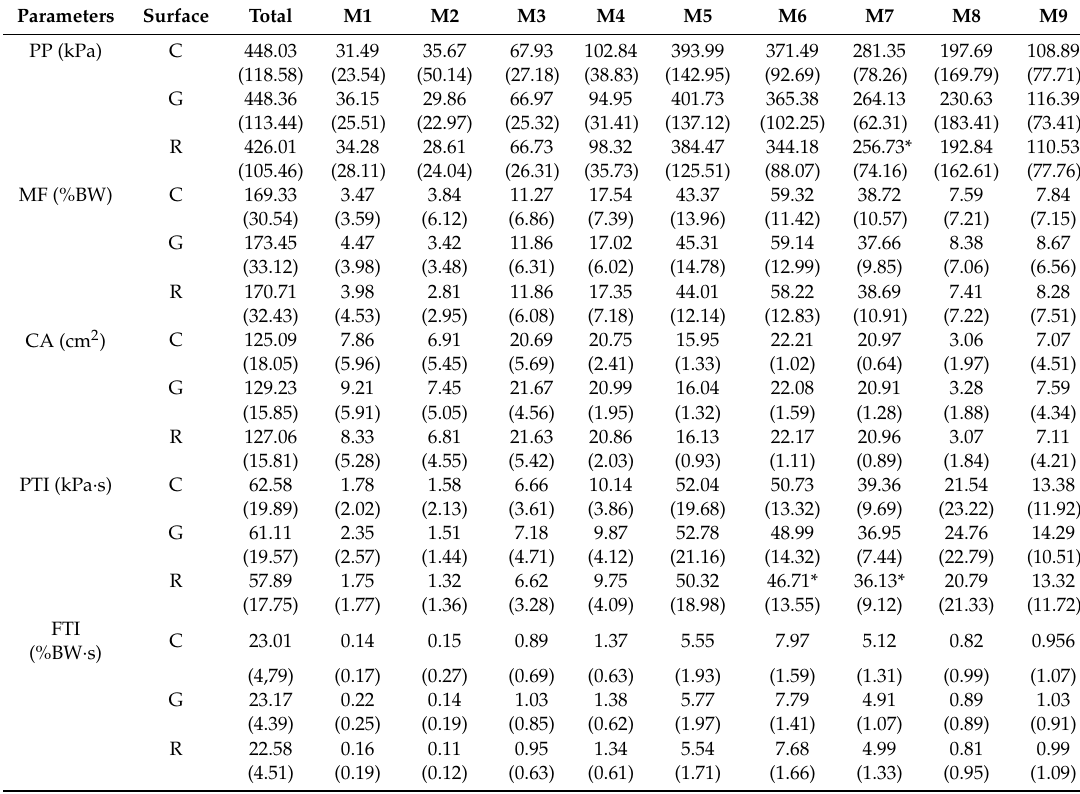
Table 1. Comparison of Plantar Loads between Di ff erent